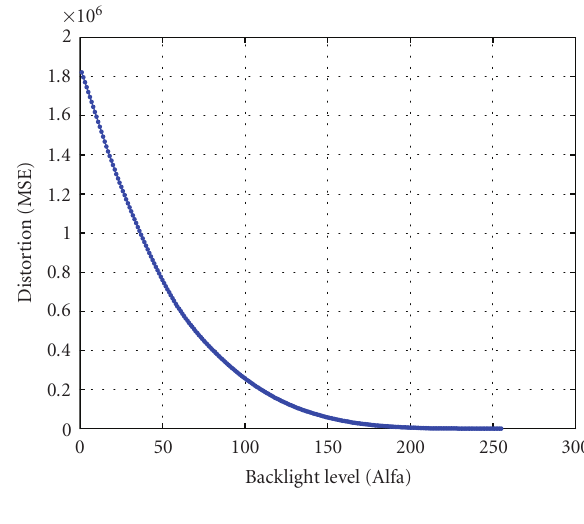
Figure 5: Power saving versus backlight level.